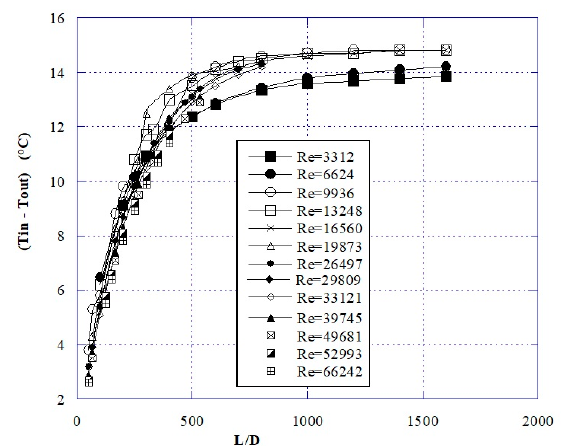
Figure 7. Temperature variation in the EAHX during summer as a function of the tube form factor for different Reynolds numbers.